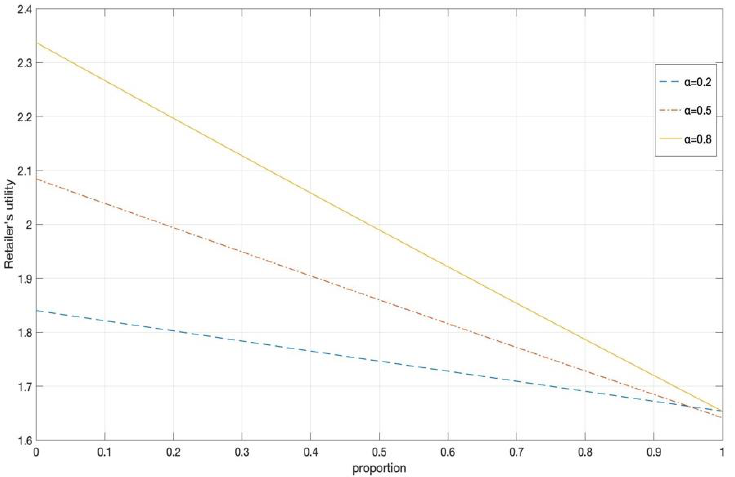
Figure 5. The effects of different adverse unfair aversion coefficients on the retailer utility.